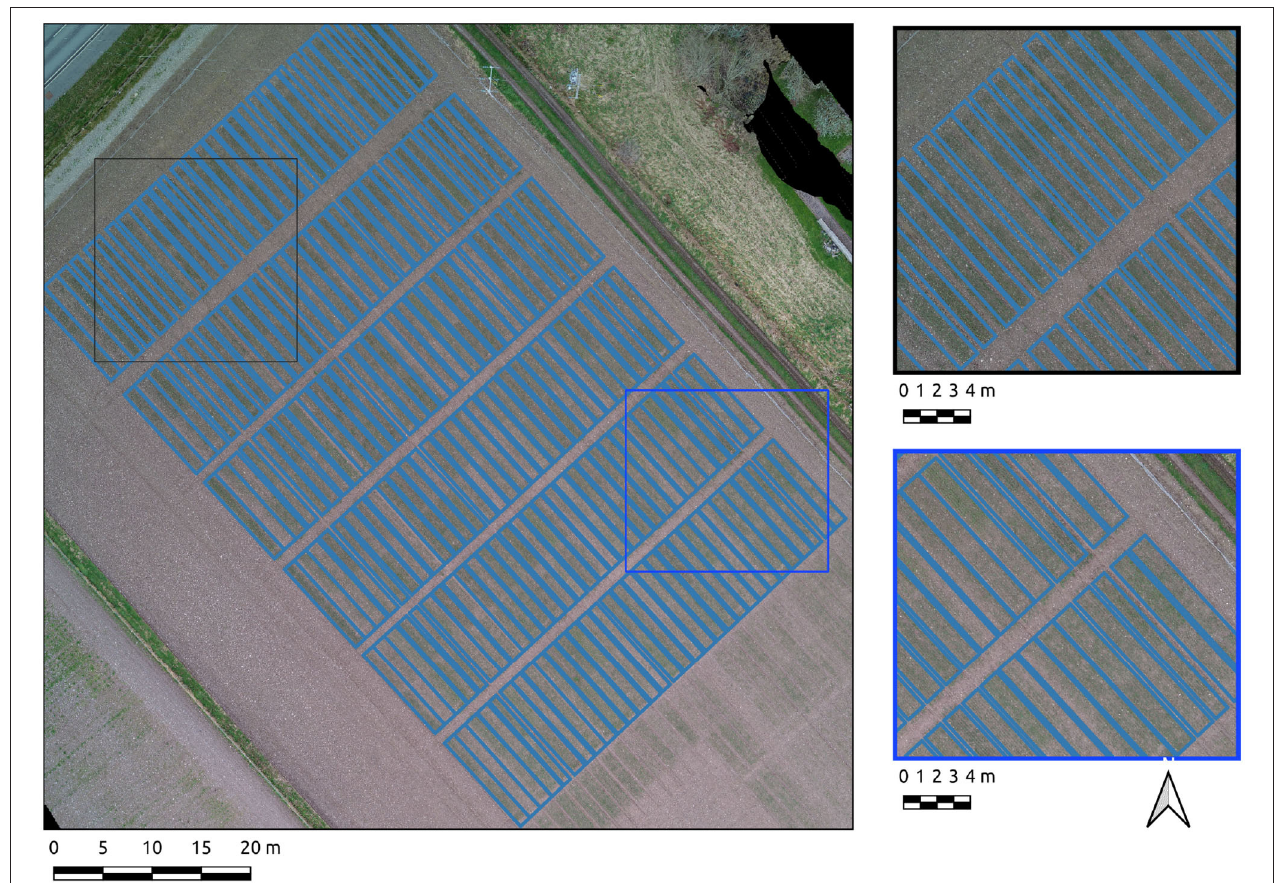
FIGURE 7 | Segmentation results on the Cae Gwn 7 site plots set using the Canny-based approach.